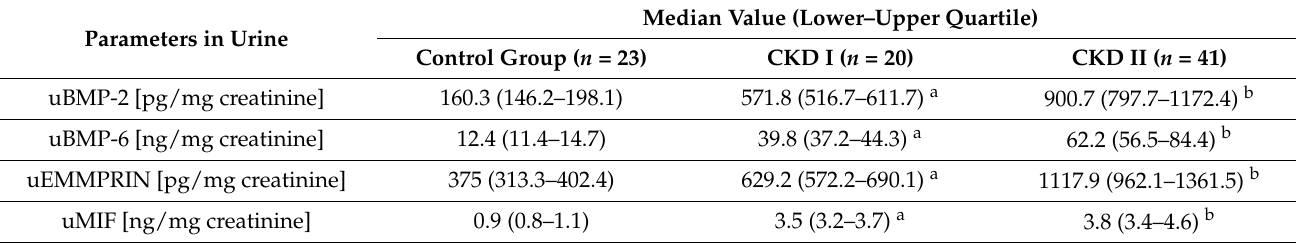
Table 3. Urine concentrations of examined parameters in children with CKD and in the control